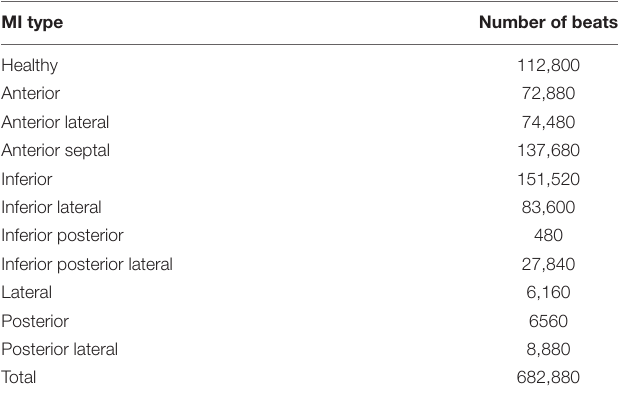
TABLE 1 | Number of 12-lead ECG beats analyzed for healthy subjects and each type of MI.